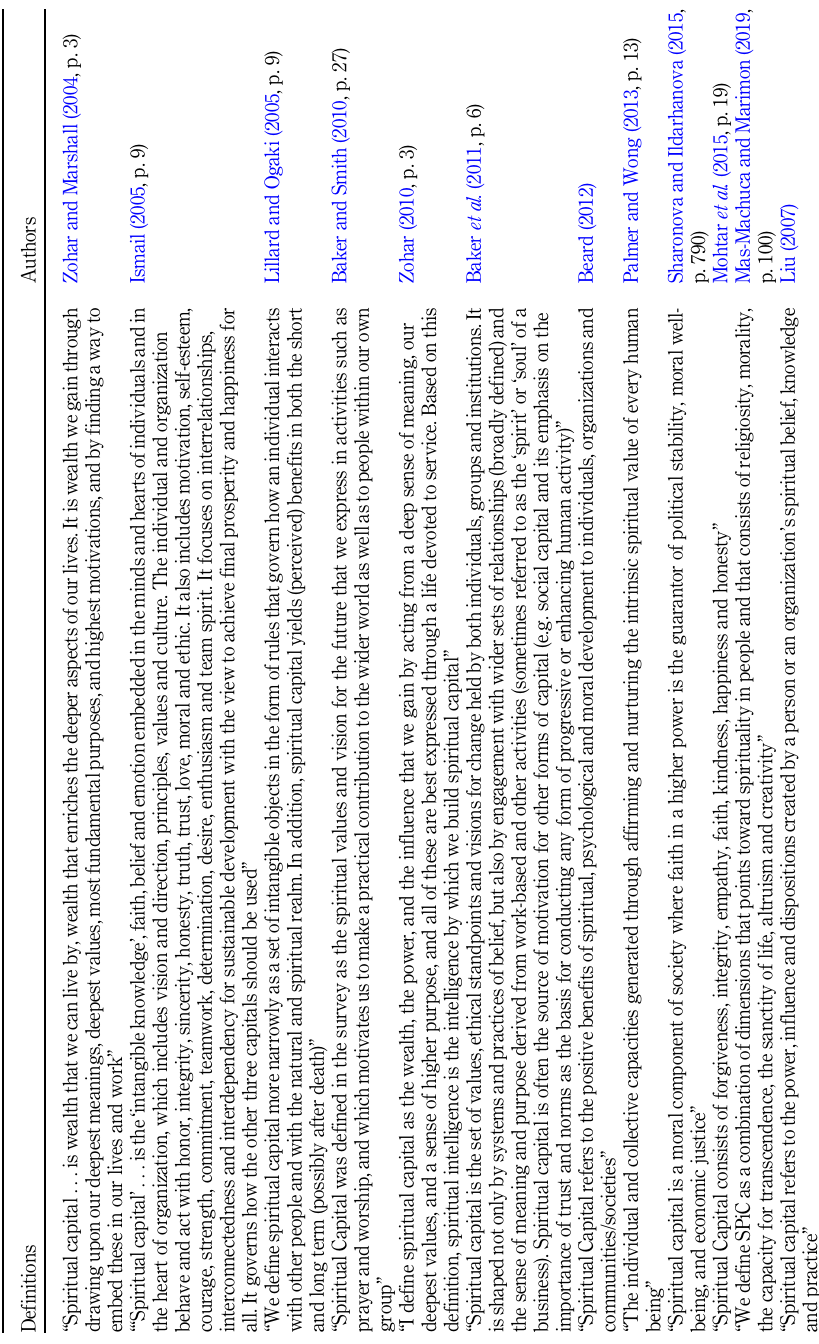
Table 1. Some definitions of spiritual